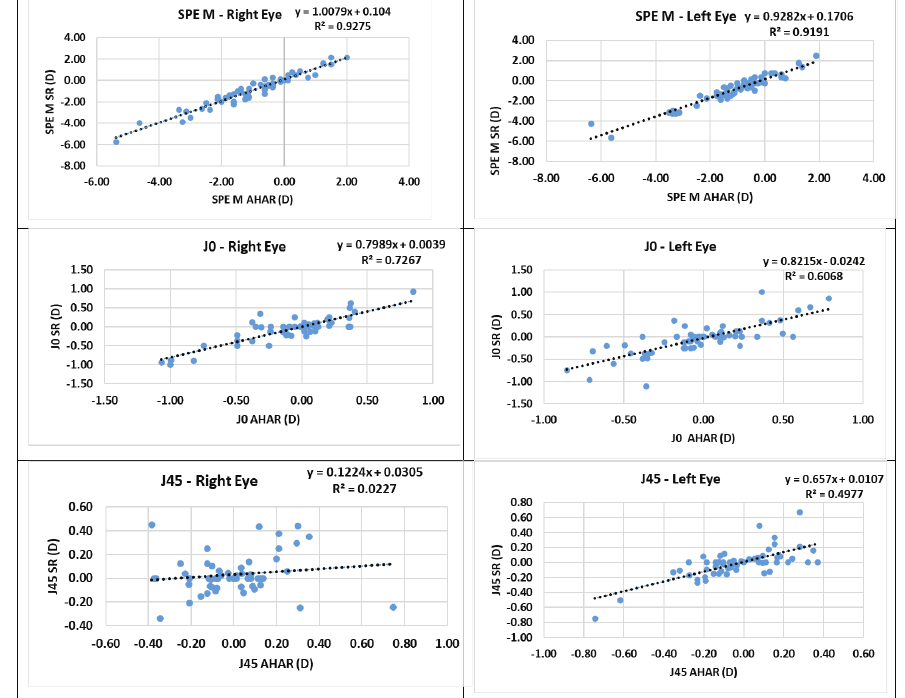
Figure 2. The correlation of the three power vectors in both the eyes.